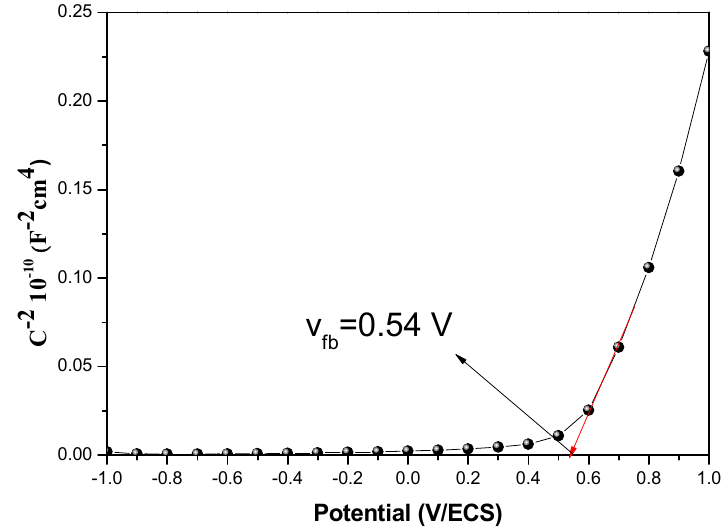
Figure 7. The capacitance-potential characteristic of ZnBi 2 O 4 in NaOH (0.1 M) solution. The diagram of electrochemical impedance spectroscopy (EIS) of the junction ZnBi 2 O 4 / The space charge width (W~3.45 nm) was calculated under optimal band bending at the interface (E − E fb ) using the following equation [59,60]: (Figure 8 Inset), corresponding to the contribution of the bulk, grains boundary, and